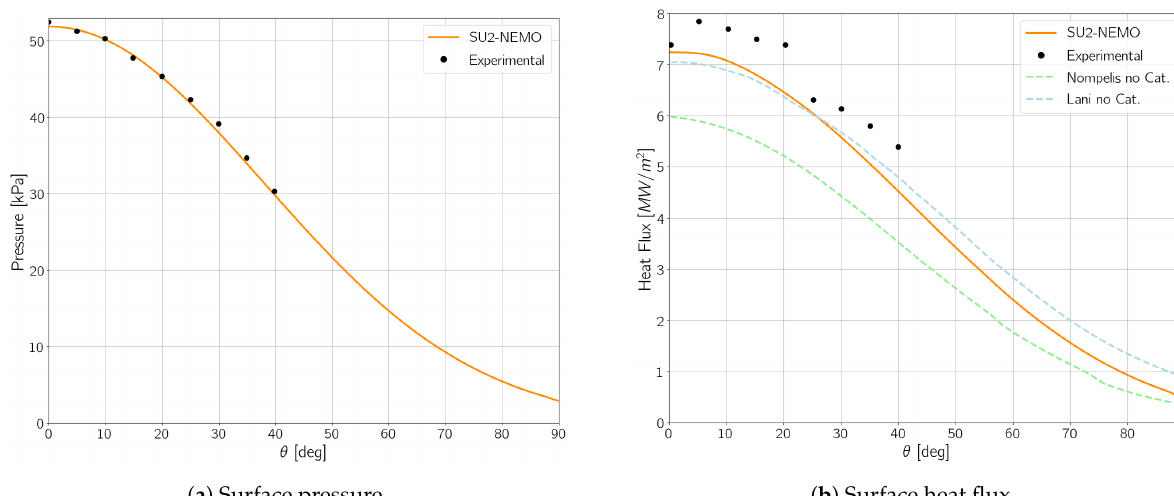
Figure 7. HEG cylinder surface plots with comparison to experimental [48]